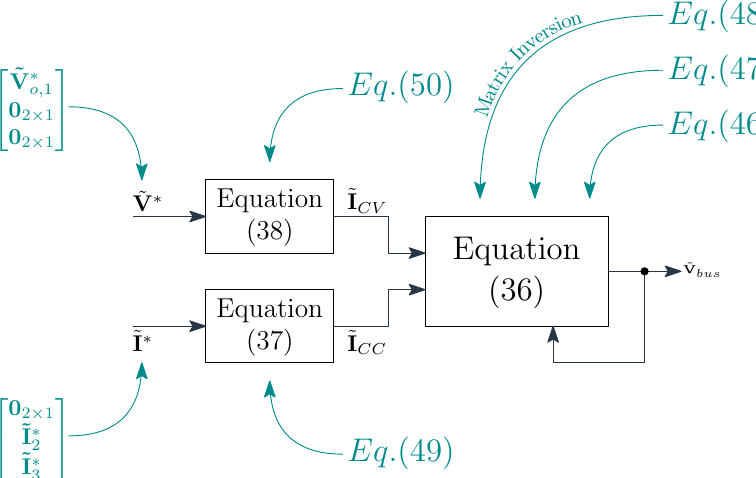
Figure A1. Relationships of the equations in Section